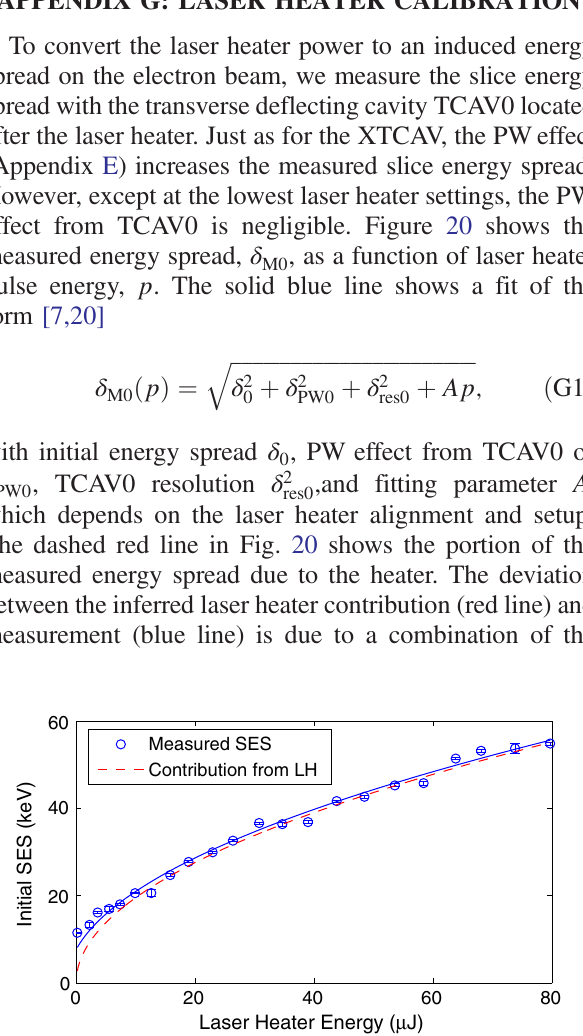
FIG. 19. Slice energy spread as a function of beam position for both the rms (green) and fwhm (blue) metrics. Light colored lines are for individual shots, and bold dashed lines show the average. Energy spreads in Fig. 9 are calculated by averaging over the portion with bold, solid lines. Average current profile of the beam shown below.